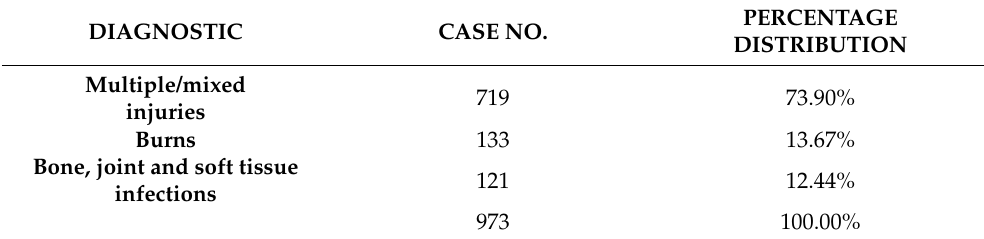
Table 1. Distribution of hospitalization diagnoses for the entire studied pathology.